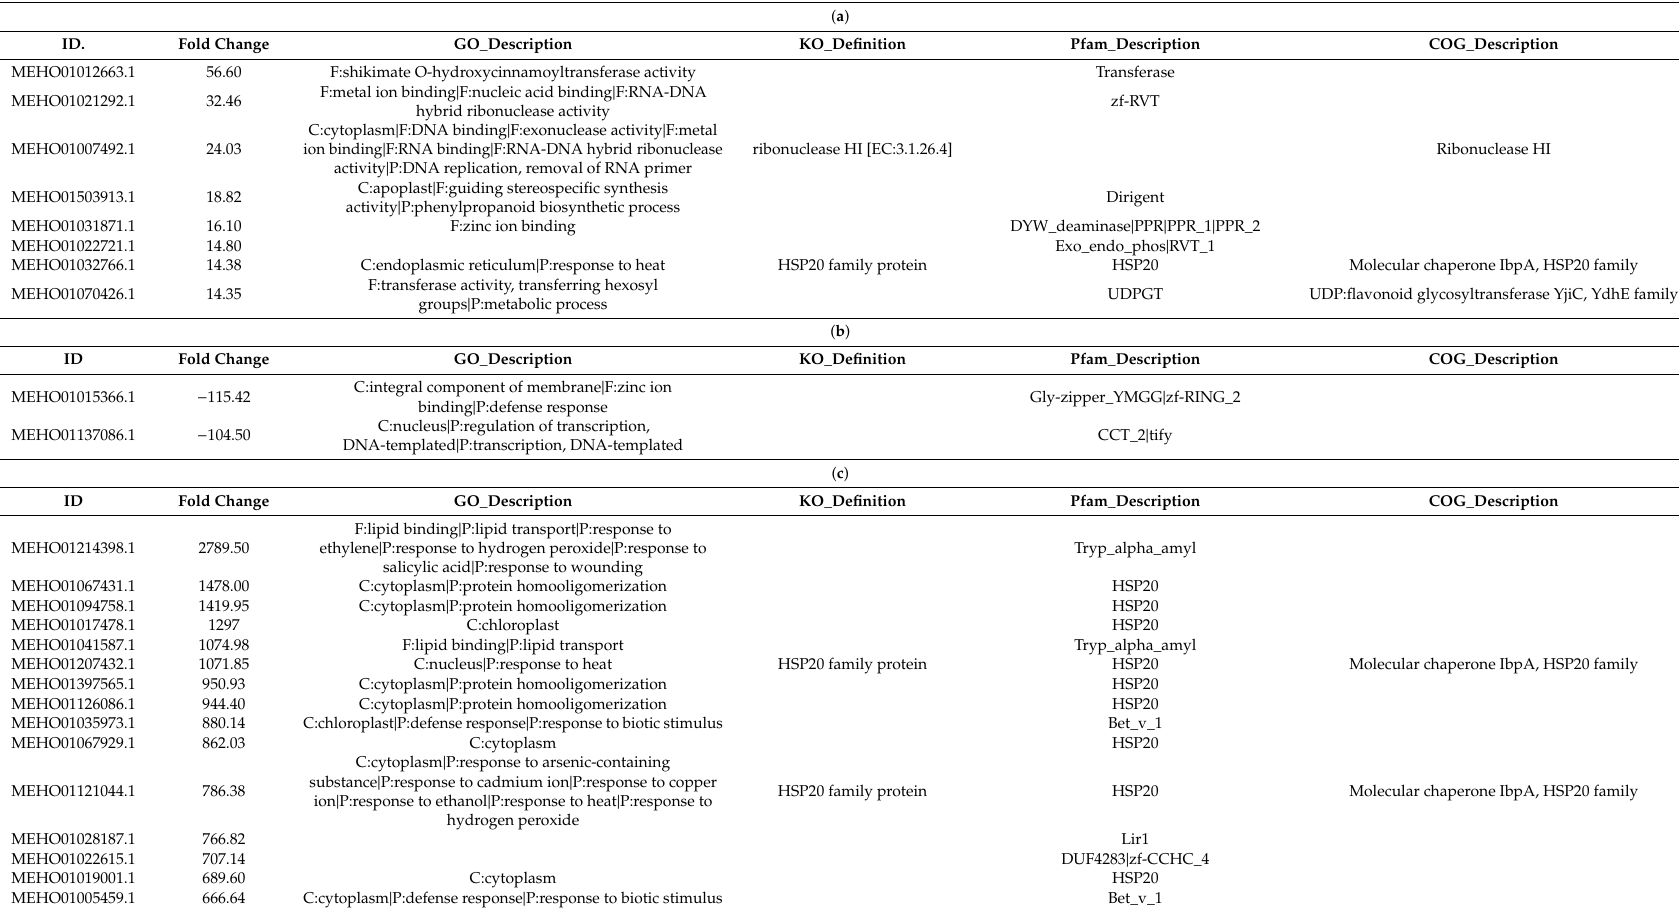
Table 2. Among the 50 genes with the highest di ff erential expression (based in the fold change value), those that have some description in the databases used are indicated in this table: GO (Gene Ontology), KO (KEGG Orthology), Pfam, and COG (Clusters of Orthologous Groups). (a) Genes overexpressed in Madrid in 2017; (b) genes overexpressed in Ciudad Real in 2017; (c) genes overexpressed in Madrid in 2018; (d) genes overexpressed in Ciudad Real in 2018. The rest of the genes can be found in the Supplementary